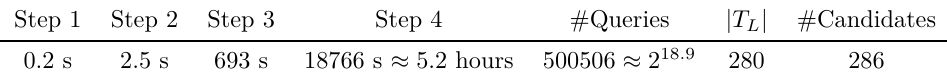
Table 2: Average execution times and other metrics averaged over 10 runs on a 16-core computer. The steps refer to the numbered list in Section 3.1. #Queries is the number of chosen-plaintext queries in step 1. #Candidates is the number of key candidates generated in step